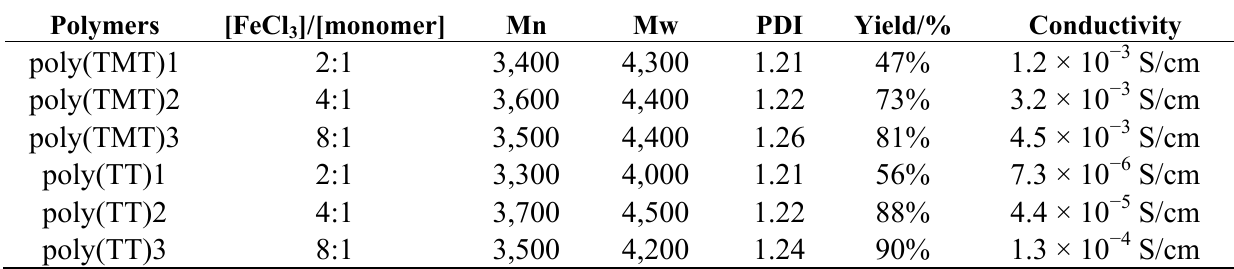
Table 1. The molecular weight, yield and conductivity of the polymers.